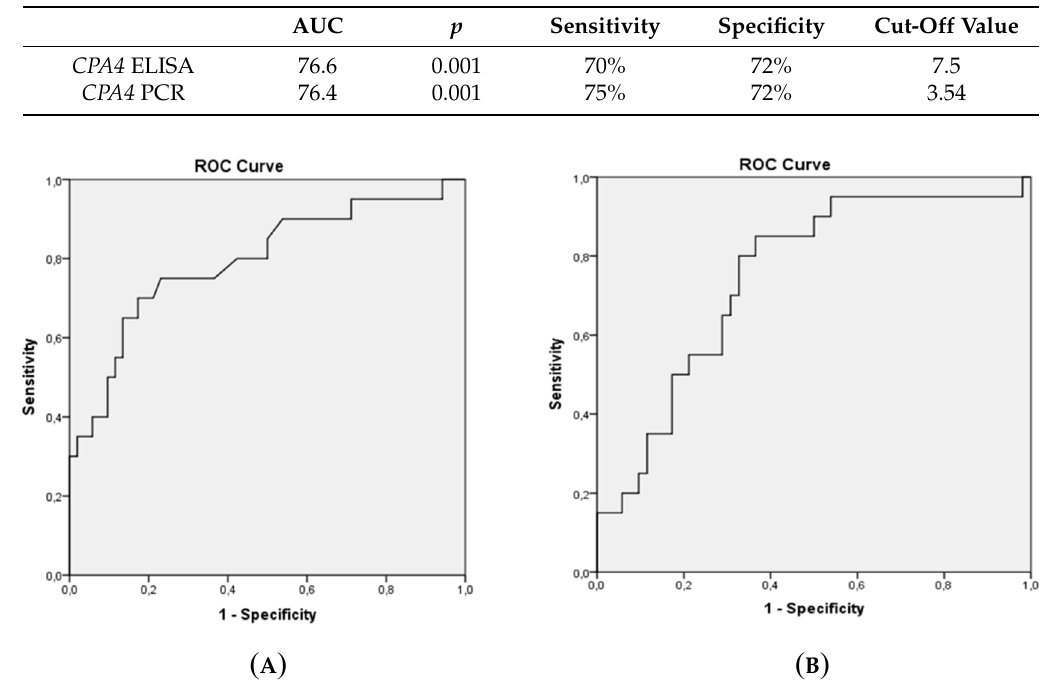
Table 4. Sensitivity and specificity at the cut-off points.